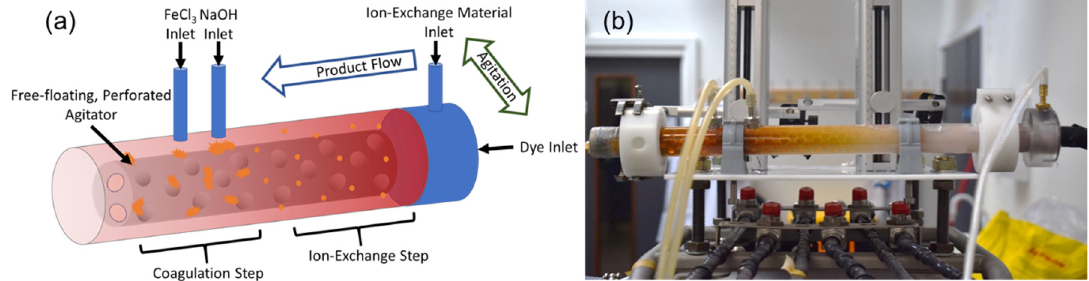
Figure 2. ( a ) Schematic representation of the ATR and ( b ) corresponding image of the equipment during operation (same orientation and flow direction).